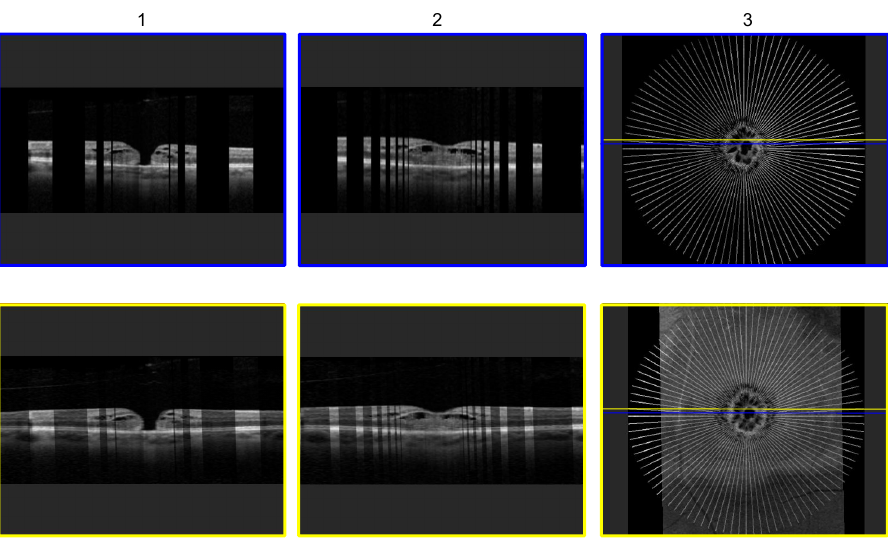
Figure 9. Comparison of an ordinary 48 radial volumetric OCT reconstruction (row 1) and a radial and linear fused volumetric OCT reconstruction (row 2). Two different, randomly chosen, cross- sectional B-scan slices were chosen (column 1 and column 2). In row 1, column 1 and column 2, the dark areas represent missing information. In row 2, column 1 and column 2, the brighter areas represent information provided by the radial volumetric OCT and the darker areas information provided by the linear volumetric OCT. The last column shows the top view of each reconstruction technique corresponding to the images in the same row, with the colored lines indicating the location of the cross-section from which the B-scan slice